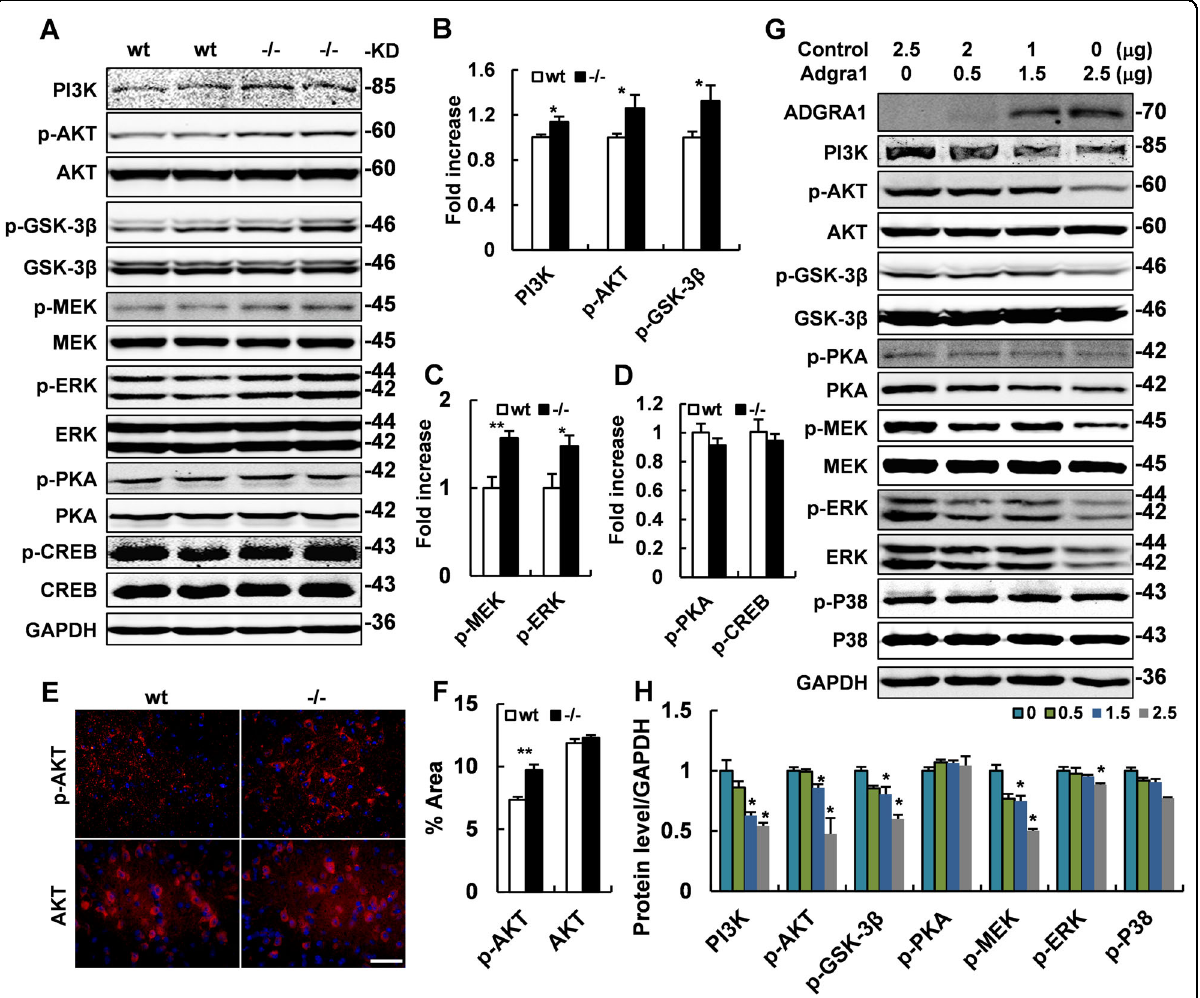
Fig. 7 ADGRA1 de fi ciency in male mice enhances PI3K/AKT/GSK3 β and MEK/ERK pathways in the hypothalamus. A Protein levels of GPCR mediated pathways analyzed by western blot. GAPDH is used as a loading control. B Quantitative analysis of relative intensities of PI3K/AKT/GSK3 β pathway. Relative intensities of p-AKT and p-GSK3 β normalized to total AKT and GSK3 β , respectively, n = 5/group. C Quantitative analysis of relative intensities of MEK/ERK pathway. Relative intensities of p-MEK and p-ERK normalized to total MEK and ERK, respectively, n = 5/group. D Quantitative analysis of relative intensities of PKA/CREB pathway. Relative intensities of p-PKA and p-CREB normalized to total PKA and CREB, respectively, n = 5/ group. E Representative images of IF of phosphorylated and total AKT in the hypothalamus of both genotypes. Scale bar, 50 μ m. F Quantitative analysis of positive areas of p-AKT and total AKT in the images, n = 5/group. G pcDNA3.1b ( − ) and pcDNA3.1- Adgra1 vectors are transfected into Neuro2A cells and the cell lysates from transfected cells are assessed by western blot. H Quantitative analysis of relative intensities of pathways. Relative intensities of phosphorylated proteins normalized to total proteins, respectively, n = 3 independent experiments. * p < 0.05, ** p < 0.01 vs. controls. Data represent mean ±